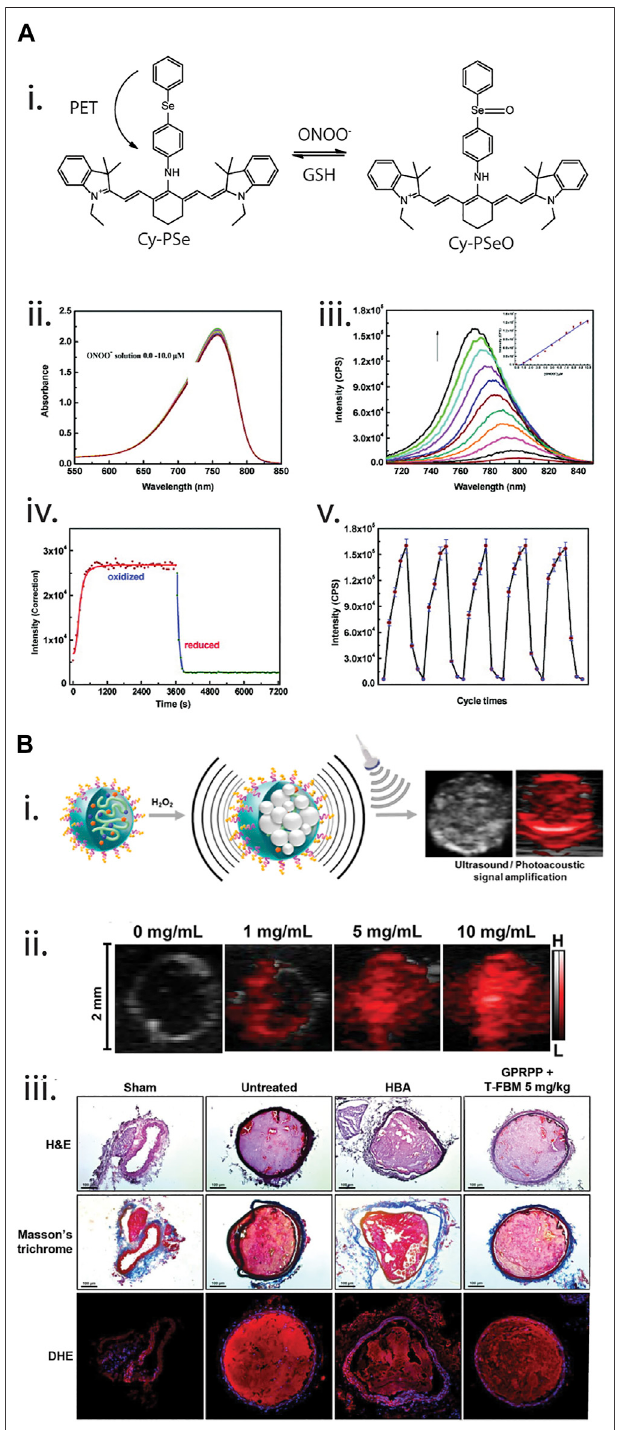
FIGURE 6 | (A) Near-infrared cyanine-derived fl uorophore for dynamic monitoring of peroxynitrite (ONOO − ). [(A), i] . Reaction pathway of the fl uorophore,whereinitiallyitisnon- fl uorescentduetoaphotoinducedelectron transfer (PET) between the cyanine structure and the phenylselenyl group. However, onceoxidized by ONOO − , the structure can fl uoresce. In the presence of glutathione (GSH), the oxidized phenylselenyl group could be